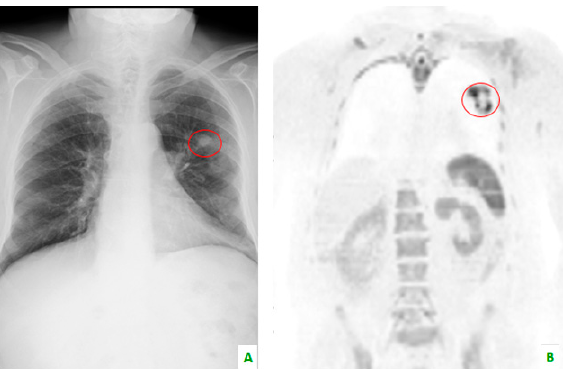
Figure 2. Bone localizations of breast cancer in the coronal plane: scapula and vertebral metastases (in the red circles). ( A ) DWI with a “positron emission tomography (PET)-like” view. The right scapula and one lumbar vertebra present an alteration of diffusivity. ( B ) T1 DIXON showing the hypointensity of the scapula and ( C ) lumbar soma.